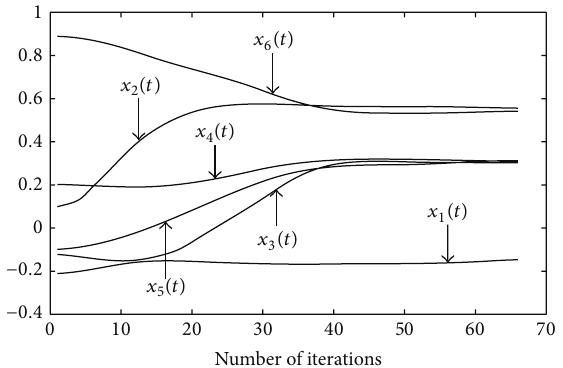
Figure 10: Trajectories of 𝜓(𝑡) = 𝑥(𝑡) 𝑇 (𝐴 + 𝐴 𝑇 )𝑥(𝑡)/2𝑥(𝑡) 𝑇 𝑥(𝑡) and 𝜙(𝑡) = √(𝑥(𝑡) 𝑇 (𝐴𝐴 𝑇 )𝑥(𝑡)/𝑥(𝑡) 𝑇 𝑥(𝑡)) − 𝑎 2 𝑥(0) as (55), which should converge to 𝑎